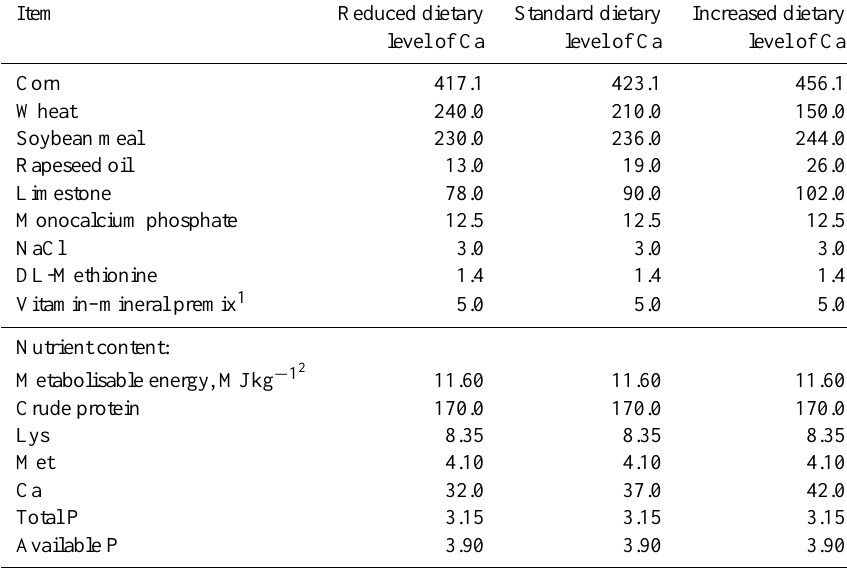
Table 1. Composition and nutrient content of experimental diets in grams per kilogram of air-dry matter. Item Reduced dietary Standard dietary Increased dietary level of Ca level of Ca level of Ca Corn 417.1 423.1 456.1 Wheat 240.0 210.0 150.0 Soybean meal 230.0 236.0 244.0 Rapeseed oil Limestone Monocalcium